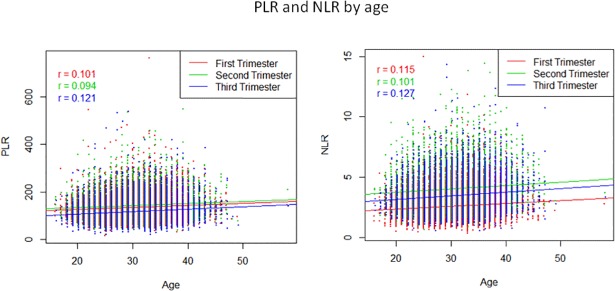
PLR and NLR by age.